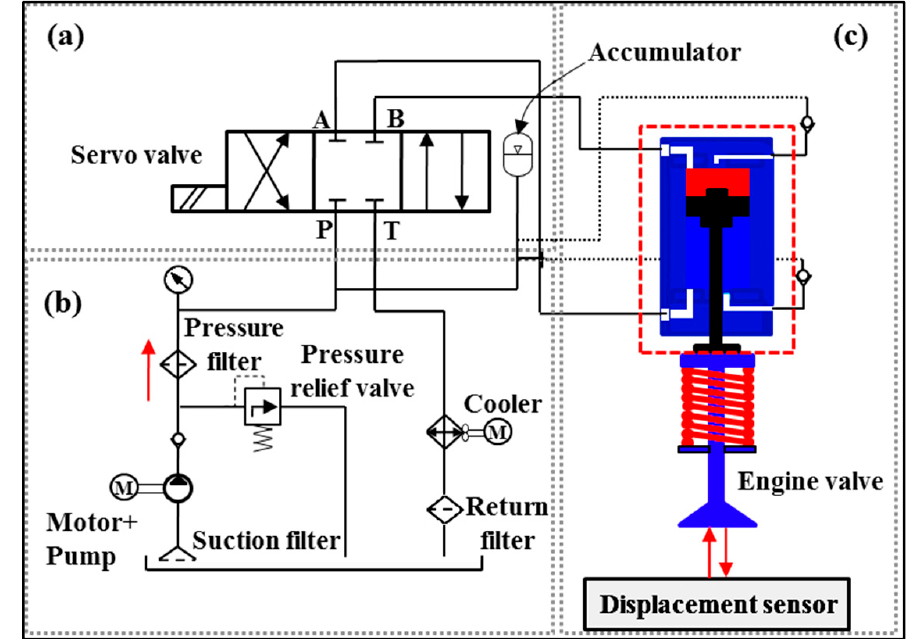
Figure 3. Schematics of the electro-hydraulic camless engine valve actuator (EH-CEVA): ( a ) proportional hydraulic valve module; ( b ) hydraulic power pack module; ( c ) EH-CEVA module.